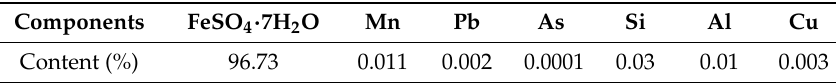
Table 3. The gold extraction rate of acid-leaching residue.